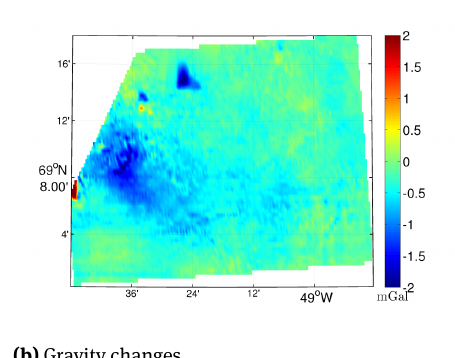
Fig. 6. Surface elevation changes over JI drainage basin (a), and the corresponding gravity changes (b) calculated using Eq. (14). The observation period is from 04.08.2007 to 02.08.2008. The area shown corresponds to the region of Jakobshavn Isbræ glacier shown in Fig. 5.